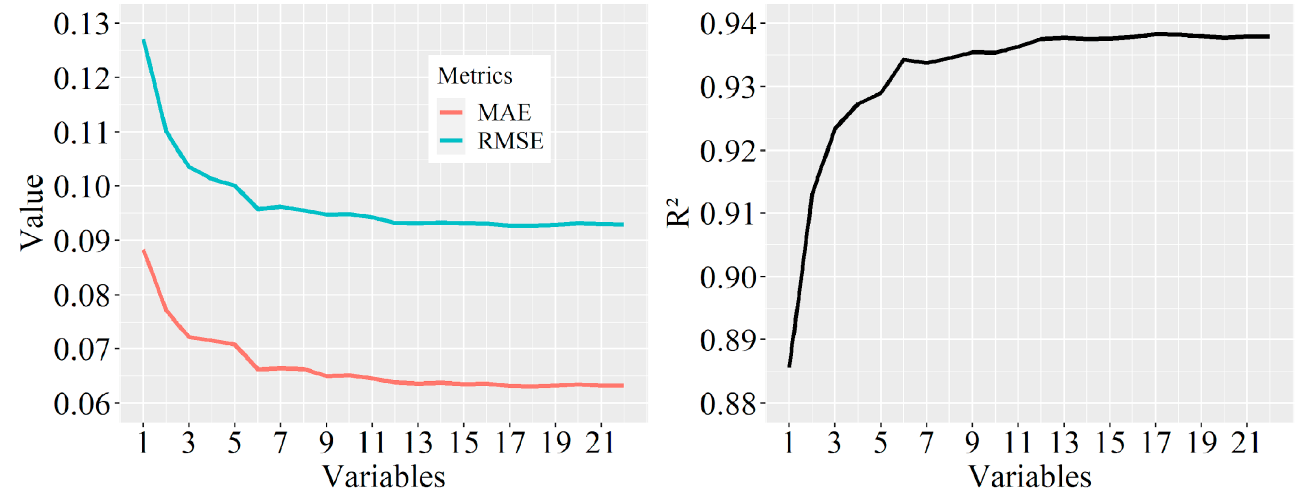
Figure 5. Statistical results for the selection of predictor variables when applying the RFE in approach 2.